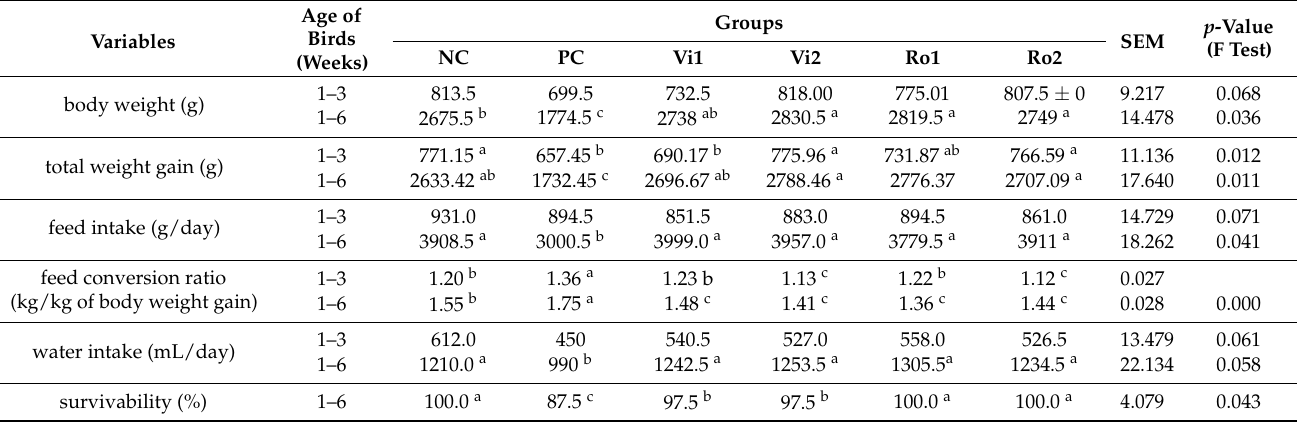
Table 4. Productive traits of broiler chickens affected by dietary vinegar and rocket salad of stressed broiler chickens ( n =